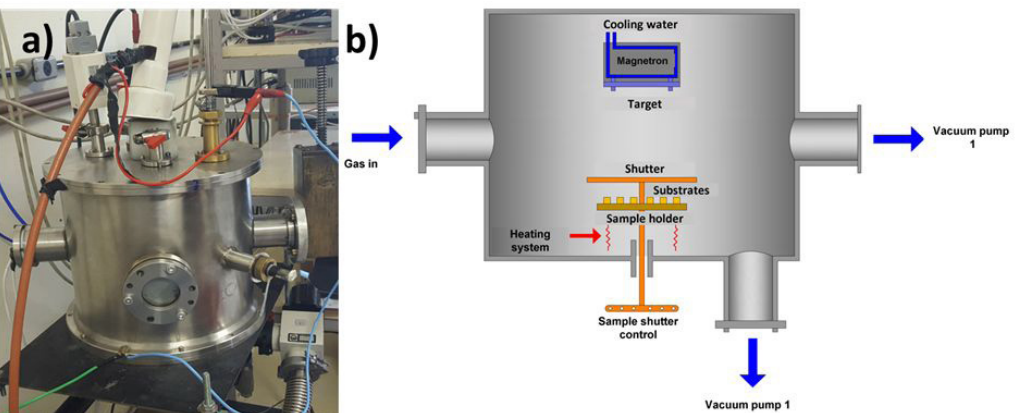
Figure 1. (a) Photography and (b) scheme of the sputtering equipment used for film